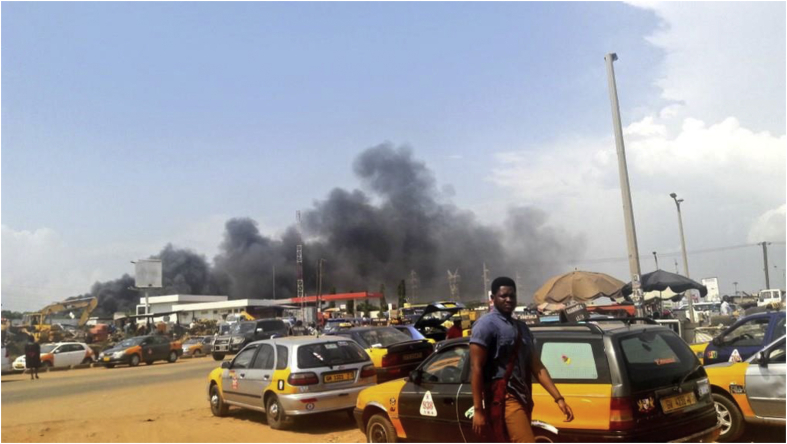
Typical Ghanaian setting showing the complex and varying emission sources.